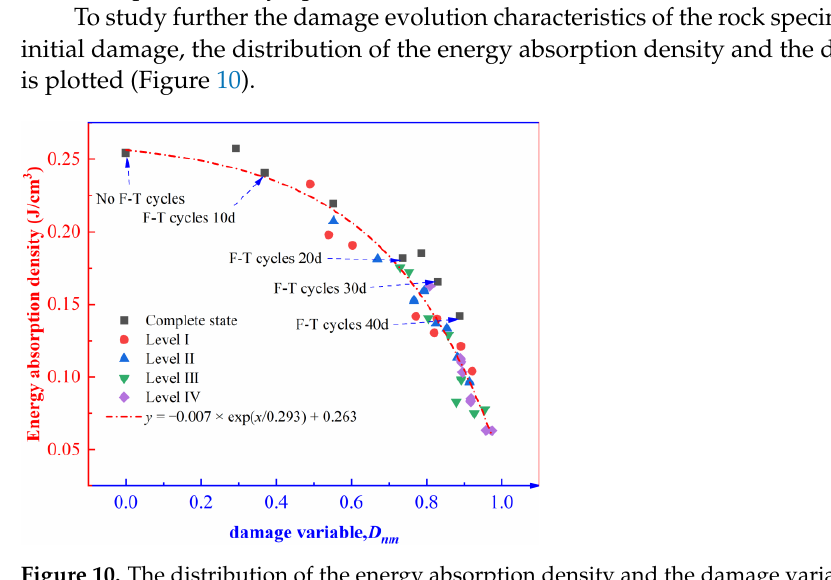
Figure 10. The distribution of the energy absorption density and the damage variable. As shown in Figure 10, the energy absorption density of the rock decreases exponen- tially with the increase in the damage variable. When the damage variable is less than 0.73, the energy absorption density is reduced by 28% from 0.25 J/cm 3 to 0.18 J/cm 3 ; when the damage variable is between 0.73 and 0.97, the energy absorption density is reduced by 67% from 0.18 J/cm 3 to 0.06 J/cm 3 . The energy absorption density of the rock spec- imens containing different levels of initial damage is mainly concentrated in the range corresponding to the damage variable from 0.73 to 0.97, during which the decrease in energy absorption density accelerates. Based on the above analysis, the damage variables of the rock specimens containing different levels of initial damage tend to stabilize under the F- T effect. After 40 F-T cycles, the energy needed for the failure of the rock specimens de- creases successively with the rising level of initial damage. The result indicates that after damage accumulates to a certain extent, the internal structure of the rock is deteriorated, thus causing low-energy fatigue albeit leading to significant damage at failure of the rock. 3.4. Fractal Features of Rock Fragments Under the external load, the energy in the rocks is rapidly accumulated, transformed, and released, thus inducing the propagation, extension, gathering, and coalescence of in- ternal microcracks and micropores and fragmentation of the rocks. The evolution of the internal spatial structures of the rocks shows the self-similarity, which inevitably causes broken rock fragments to exhibit a corresponding self-similarity. Under impact load, the fractal dimension ( D s ) of the rock fragments is related to the internal structural change of the rocks, so the fractal dimension ( D s ) can be used to quantify the changes in complex structures in the rock. Therefore, the fractal theory and the law governing the dissipation of energy were introduced to perform in-depth research on the structural deterioration process of the rock specimens containing initial damage under the F-T effect. Standard sieves with mesh apertures between 0.154 and 37.5 mm were used to screen the broken rock fragments, and mass of rock fragments screened by each sieve was measured. The standard sieves and some screened rock specimens are shown in Figure 11.